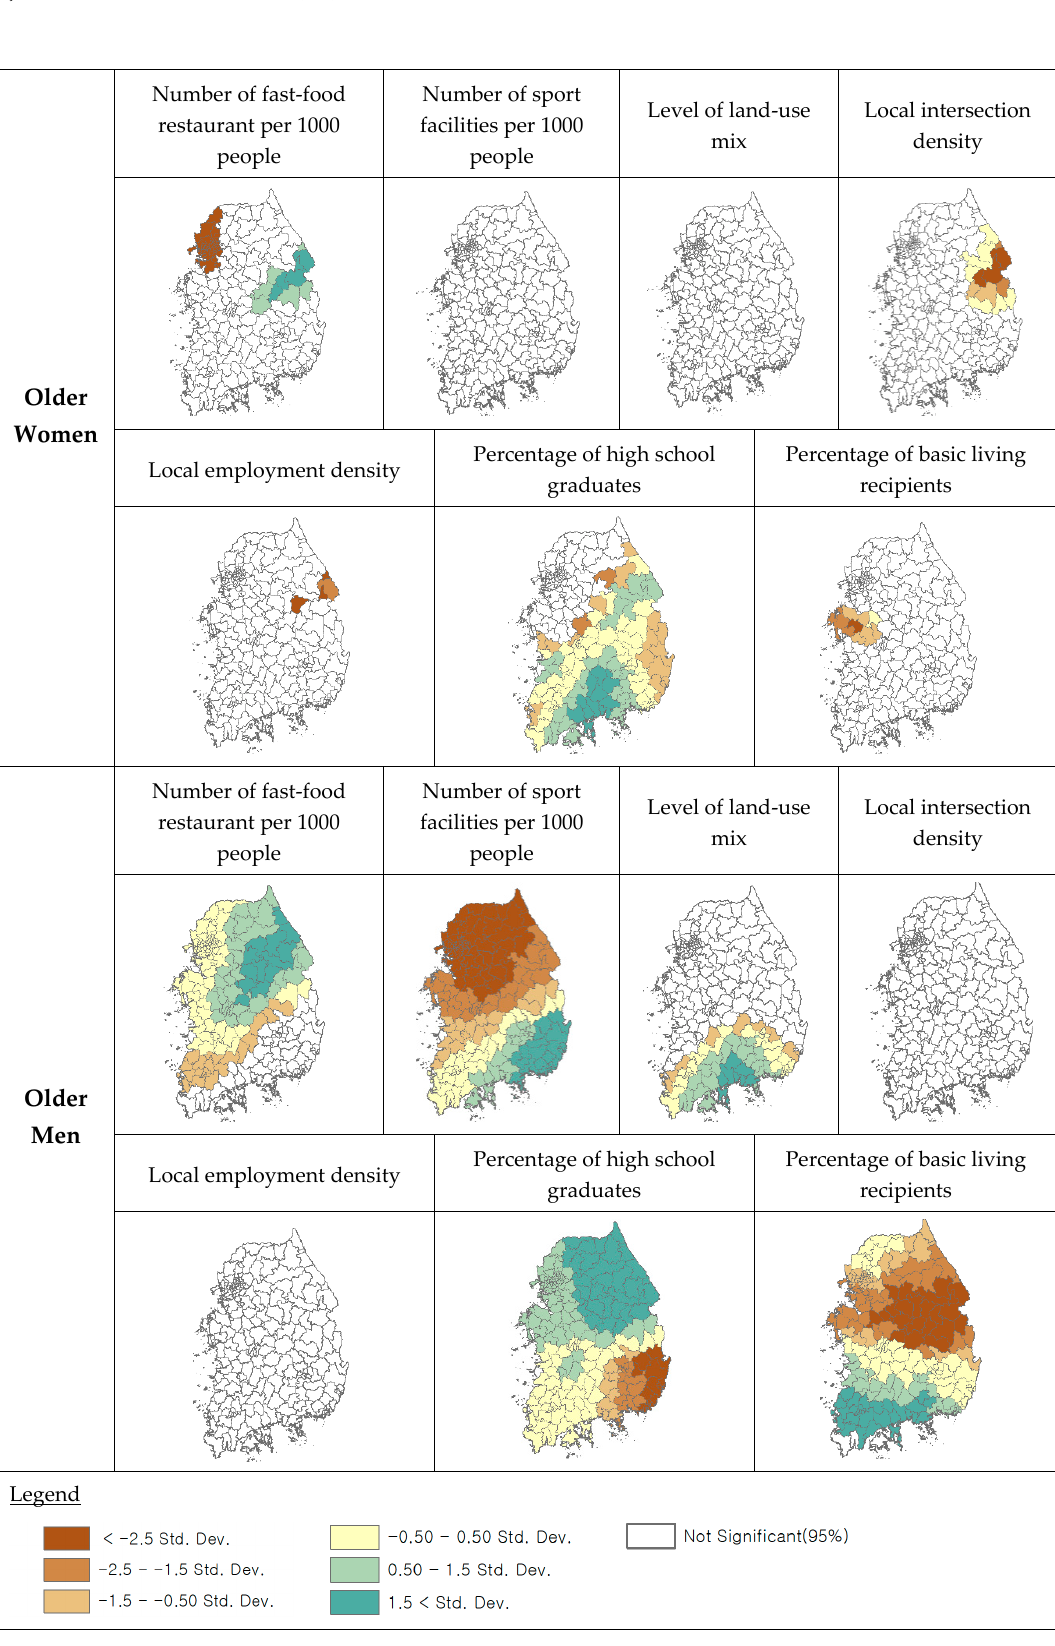
Figure 2. Localities with statistically significant local coefficients in GWR.